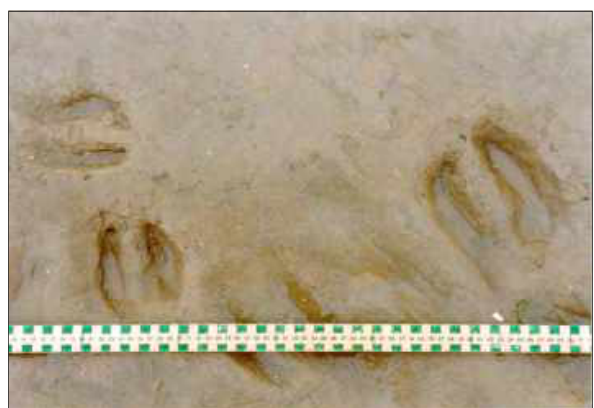
Fig 2.12 Aurochs footprints preserved in sediments within the intertidal zone at Formby (Ron Cowell/National Museums